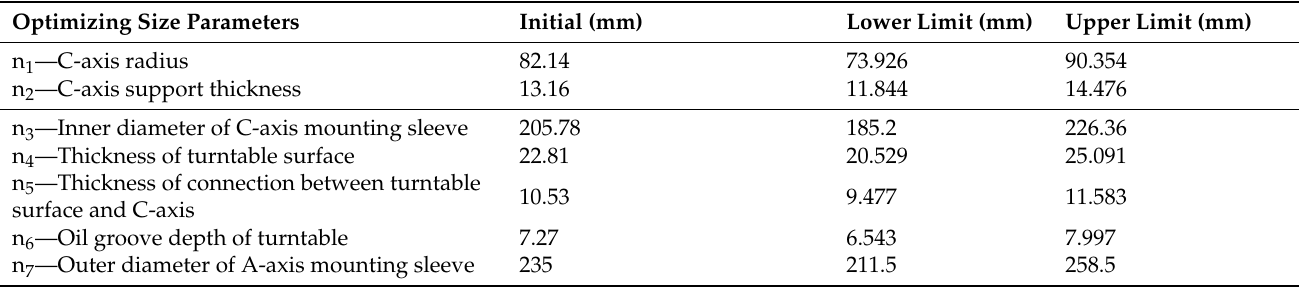
Figure 8. Optimal design parameters of A-axis. Table 5. Design variables and value ranges.